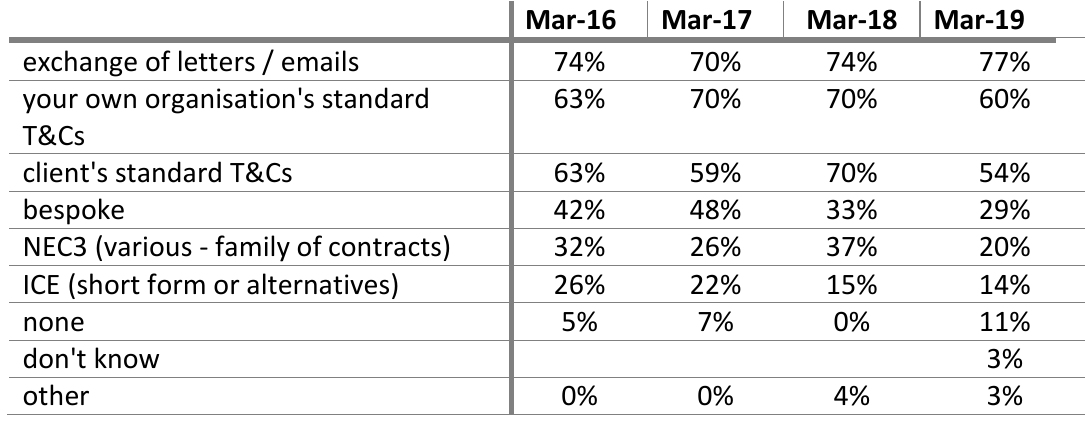
Table 17: Forms of Contract used in 2019.